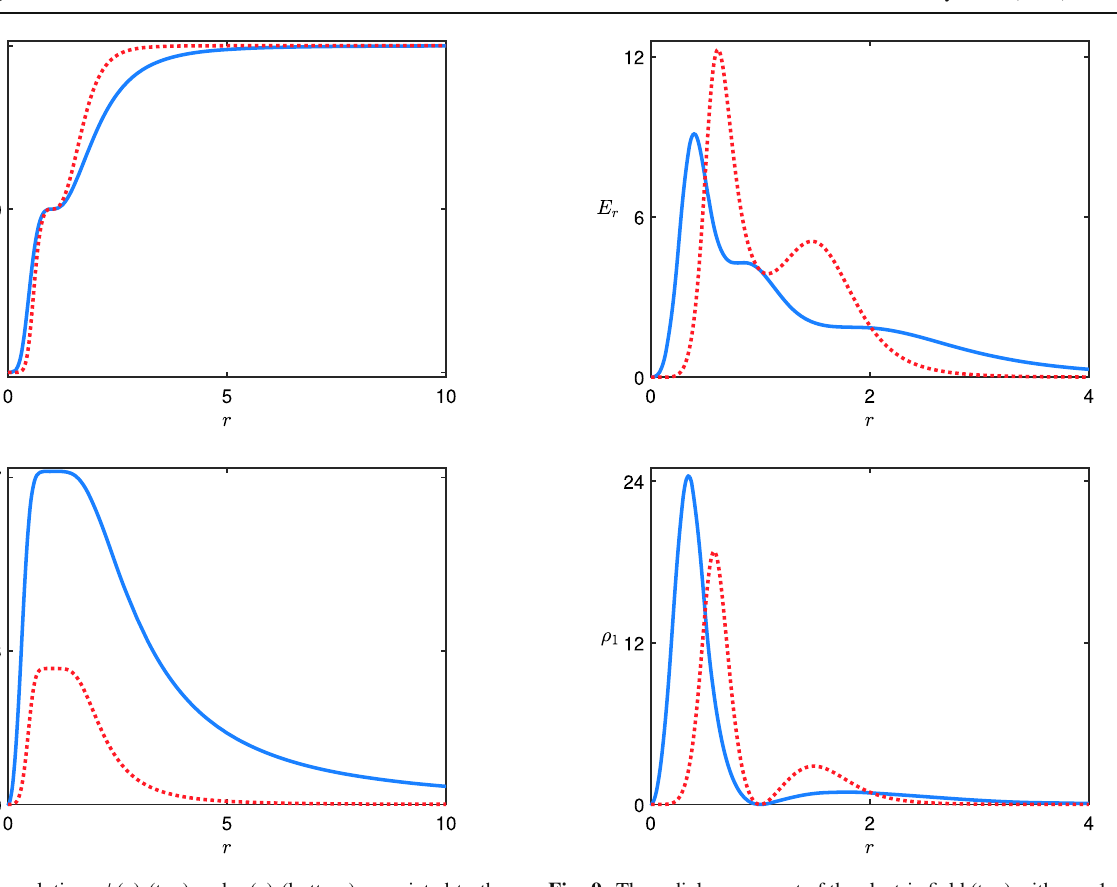
Fig. 9 The radial component of the electric field (top) with e = 1 and the energy density (bottom) associated to the model in Sect. 4.1.1 for σ = 5, α = 2, with k = 1 (solid, blue line) and 2 (dotted, red